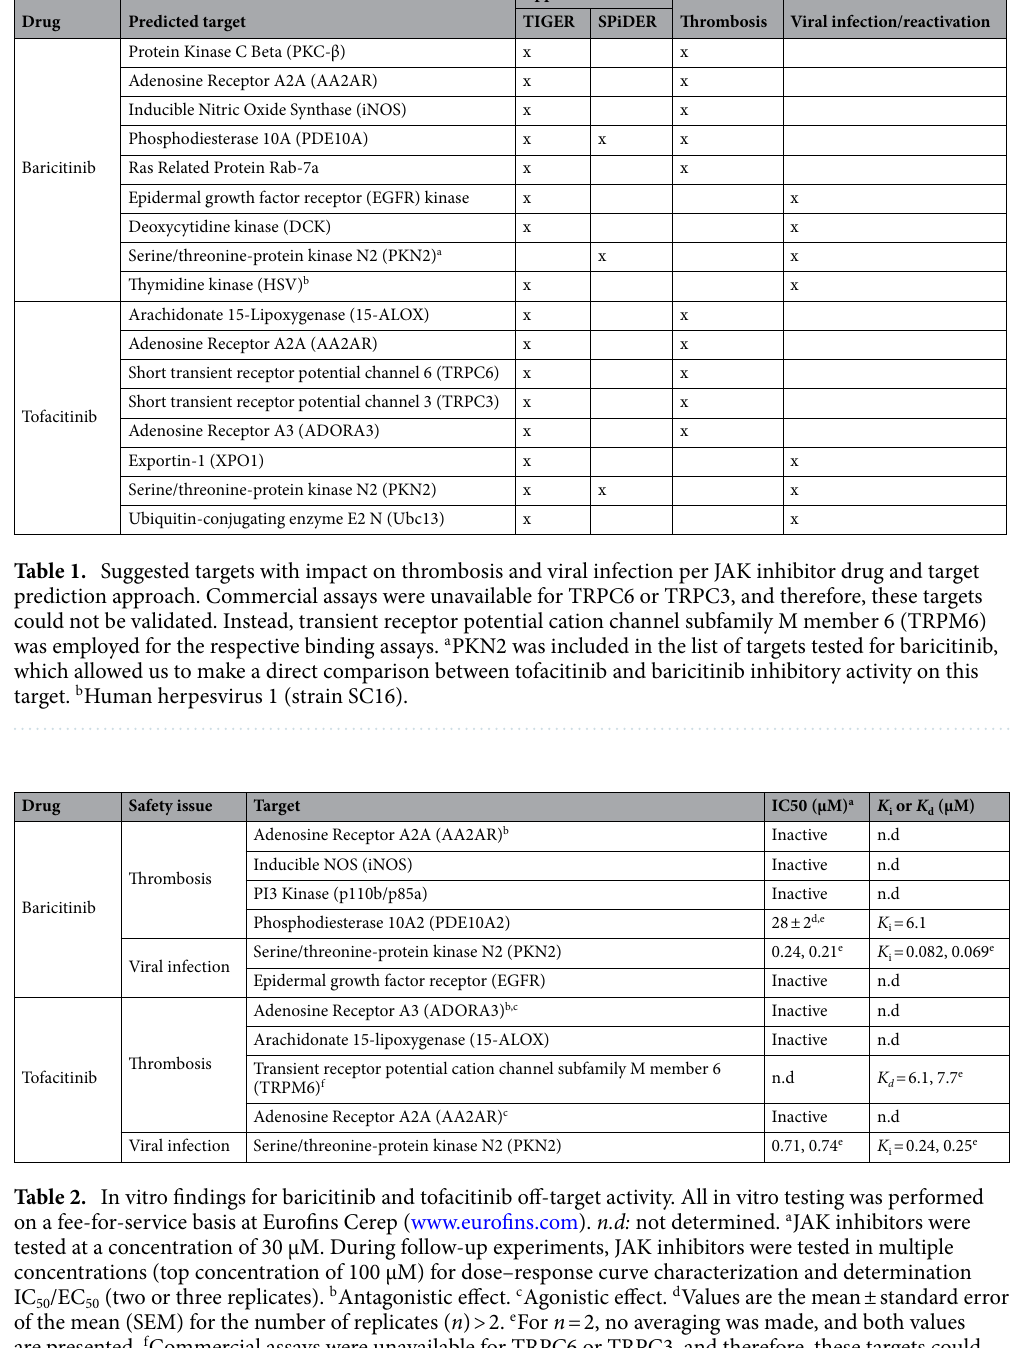
interactions. Of the 98 predicted, a total of 11 drug-target interactions were experimentally validated using biochemical or cell-based assays, based on the availability of fee-based in vitro testing services (Table 2). Among the predicted targets, two members of the Transient Receptor Potential superfamily of calcium channels were suggested, namely short transient receptor potential channels 6 (TRPC6) and 3 (TRPC3). Commercial assays were unavailable for TRPC6 or TRPC3, and therefore, these targets could not be tested. Instead, transient receptor